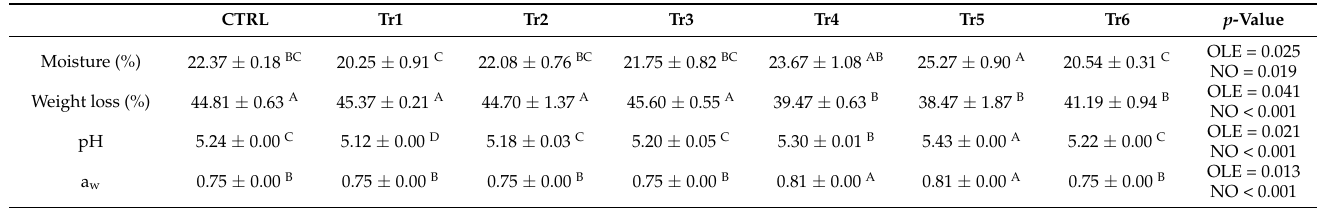
Table 4. Mean value, standard deviation, and results of the statistical analysis (two-way ANOVA) of moisture, weight loss, pH, and water activity (a w ) of the ripened sausages under investigation ( n = 3). Tr1 Tr2 Tr3 Tr4